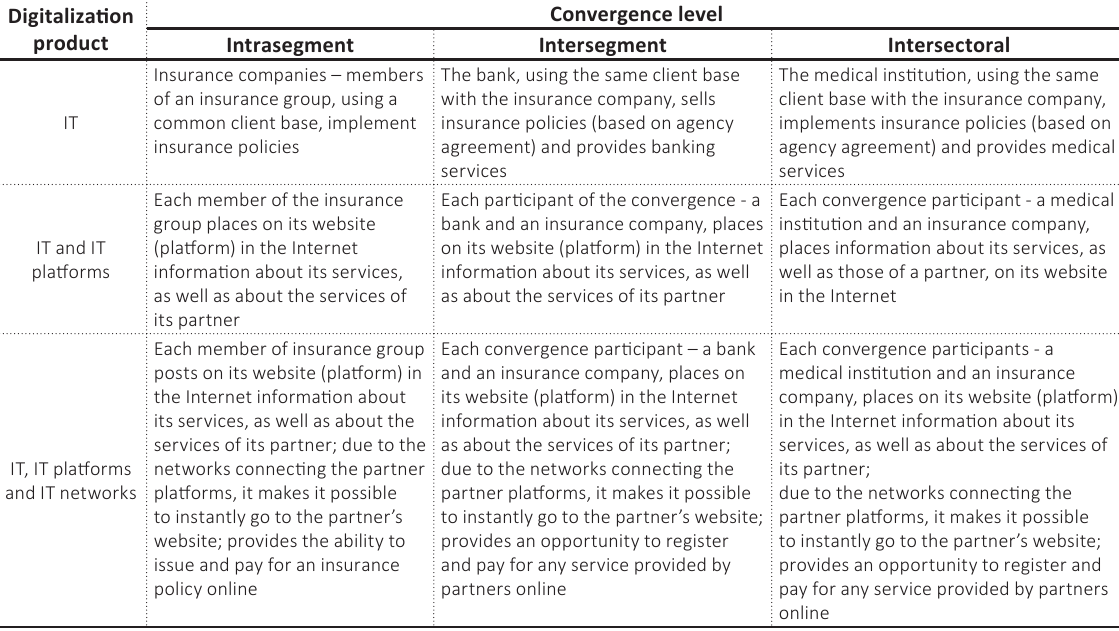
Table A1. Possible options for cooperation between participants of economic convergence, based on the use of a specific digitalization product